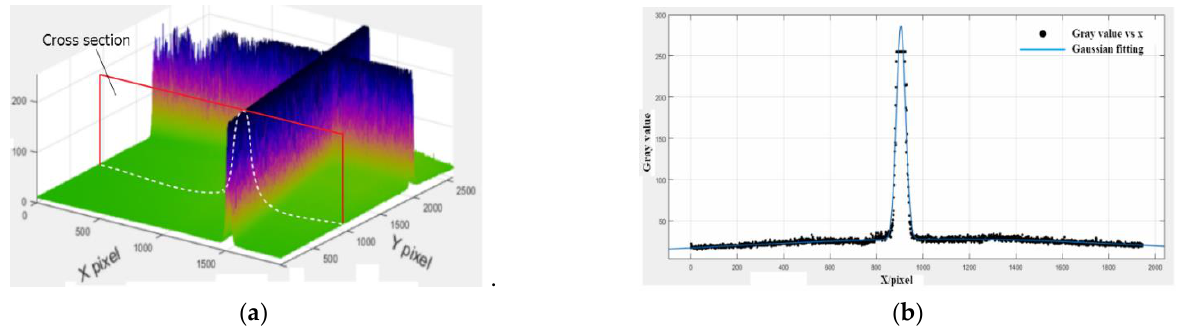
Figure 12. (a) Cross section of the cross laser pattern. (b) The gray distribution in the cross section accords with Gaussian model